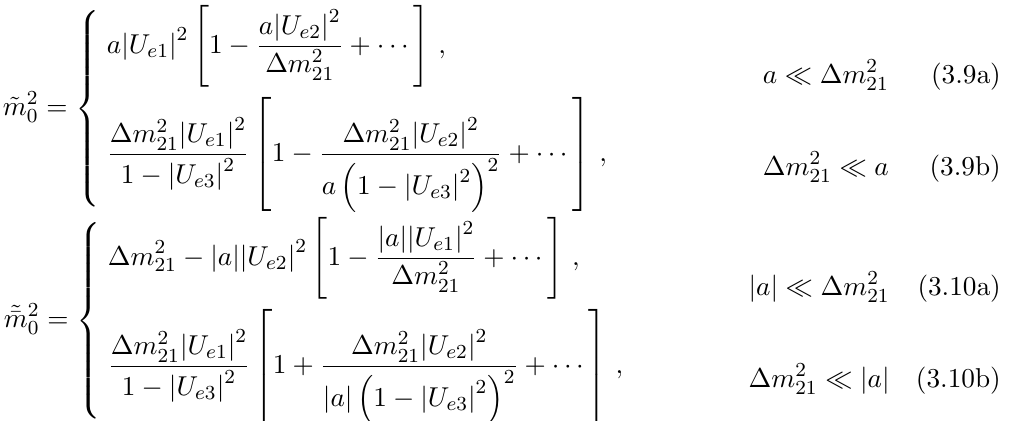
The approximation of ~ m 2 independent terms in eq.